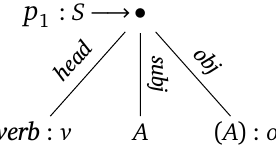
Figure 3: Labelled production rule with logical